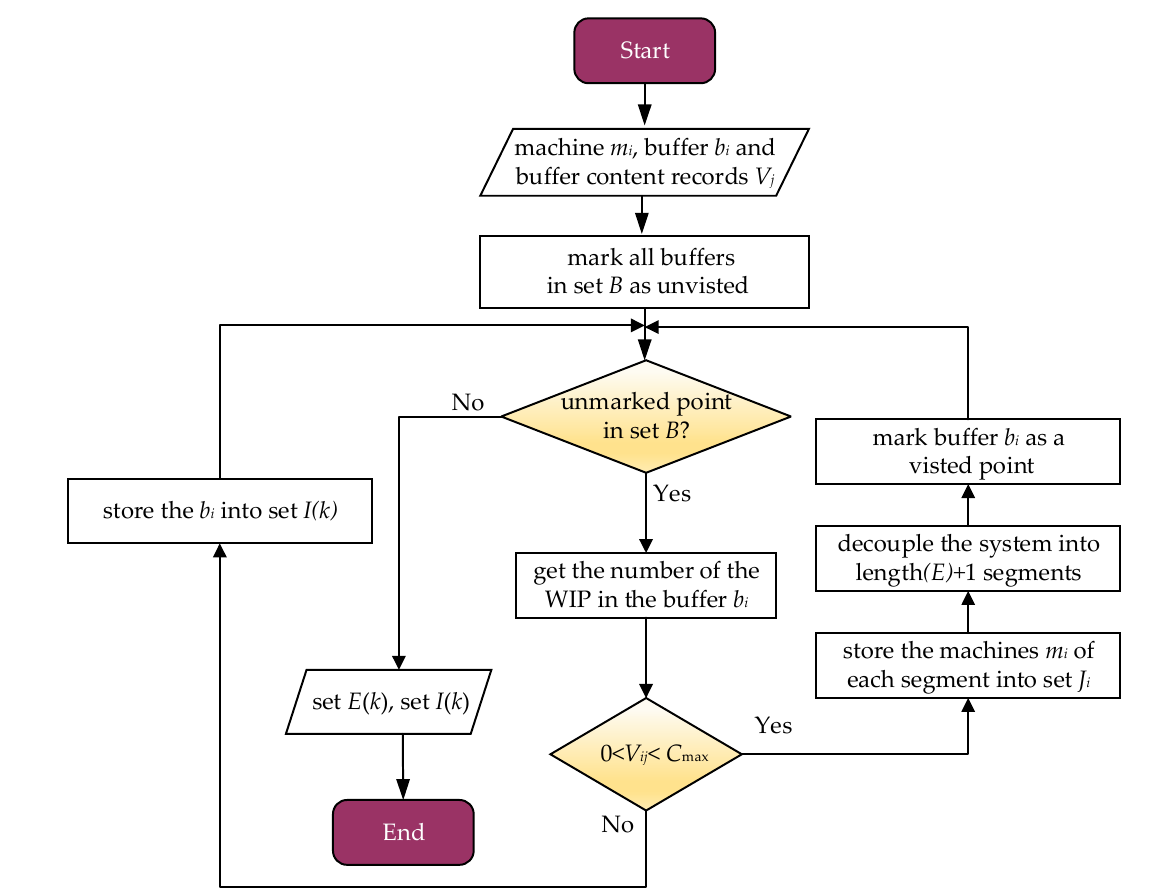
Figure 2. The effective buffering determination algorithm.